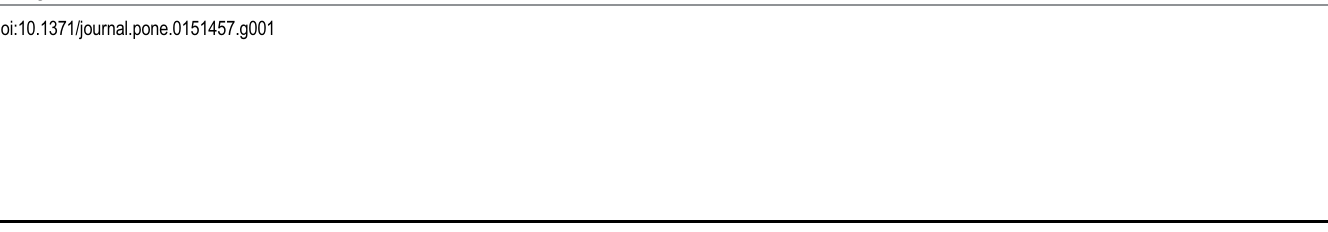
PLOS ONE | DOI:10.1371/journal.pone.0151457 March 23,